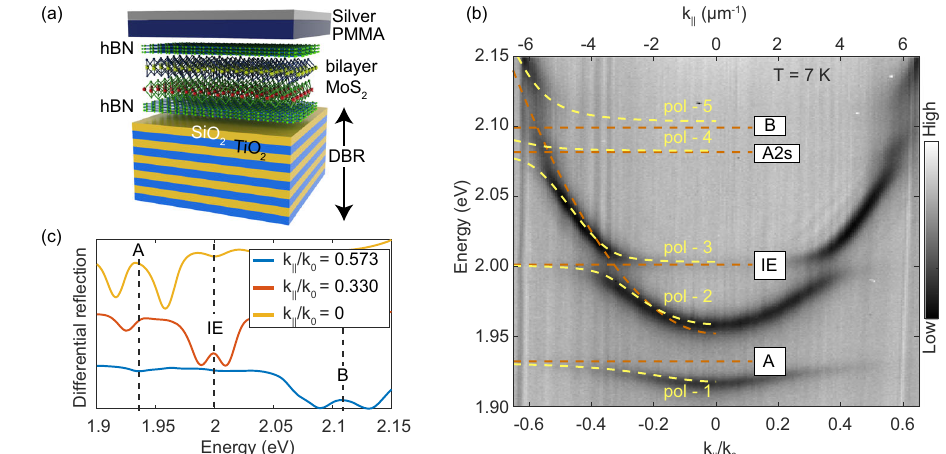
Fig. 2 | Device schematic and polariton dispersion. a Schematic of the device. The bilayer MoS 2 is sandwiched between two hexagonal boron nitride fl akes of almost similar thickness ~20nm. The entire stack is transferred by the poly- propylene carbonate (PPC) method onto a SiO 2 terminated SiO 2 -TiO 2 DBR. As the cavity spacer, a layer of 240nm thick PMMA was spin-coated on the stack. Finally, 40nm of Ag was deposited via electron beam evaporation to form a 3 λ /2 cavity, where λ is the cavity resonance wavelength. b White light differential re fl ection showing allbranchesofthepolaritonsat7K.1sand2sstatesofAexciton,IE,andB